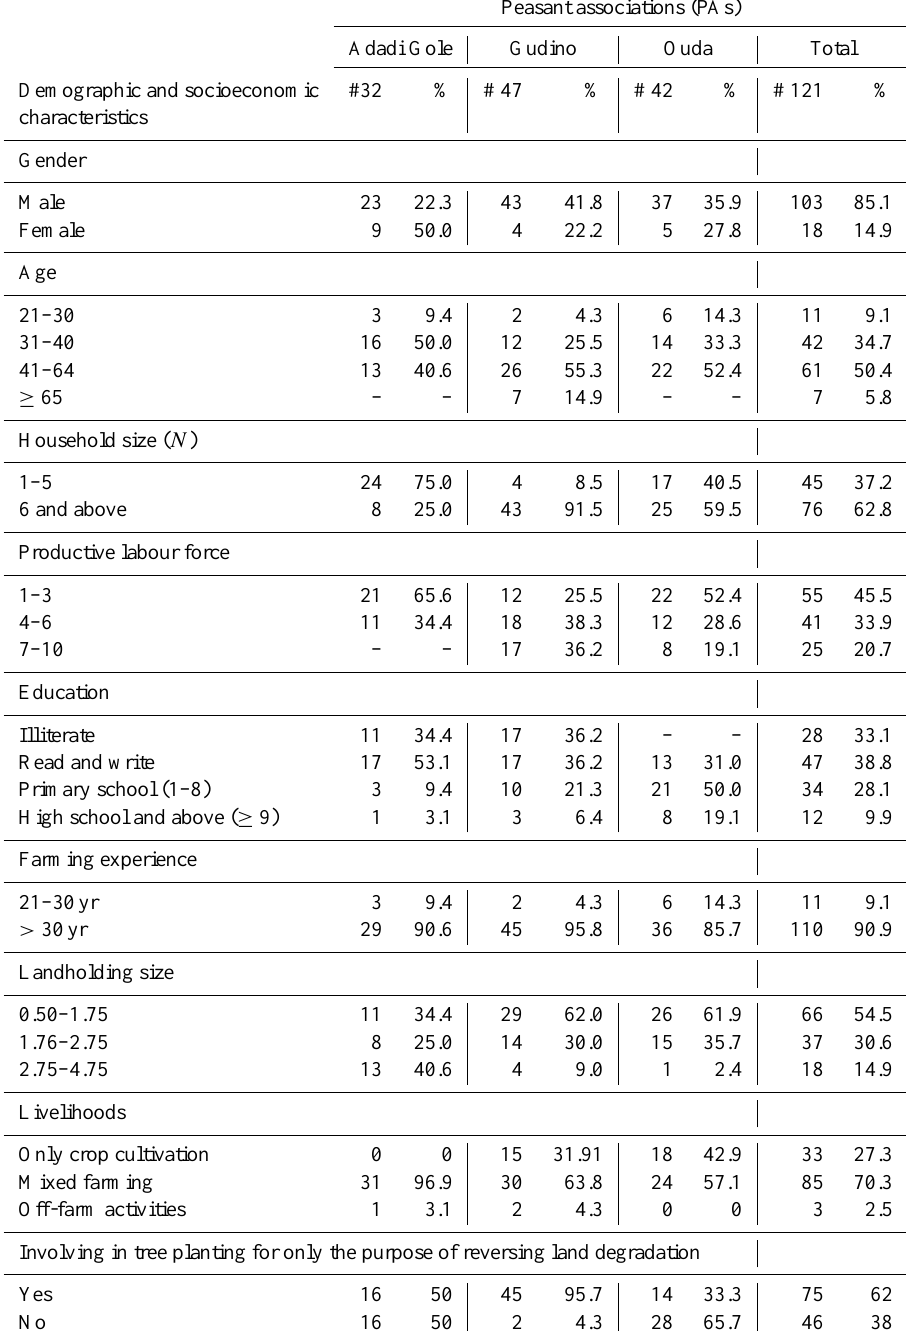
Table 3. Household demographic, socioeconomic and livelihood characteristics. Peasant associations (PAs) Adadi Gole Gudino Ouda Total Demographic and socioeconomic